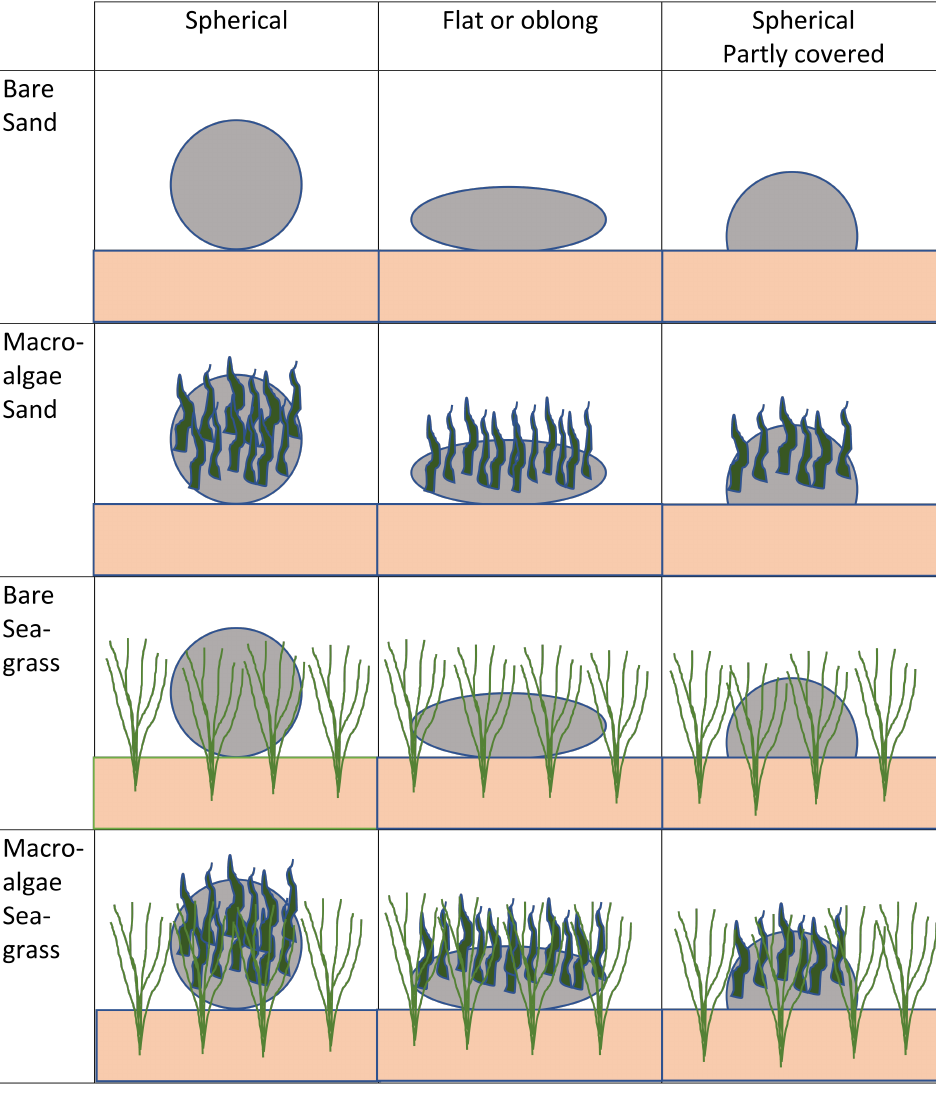
Figure 5. Twelve different boulder